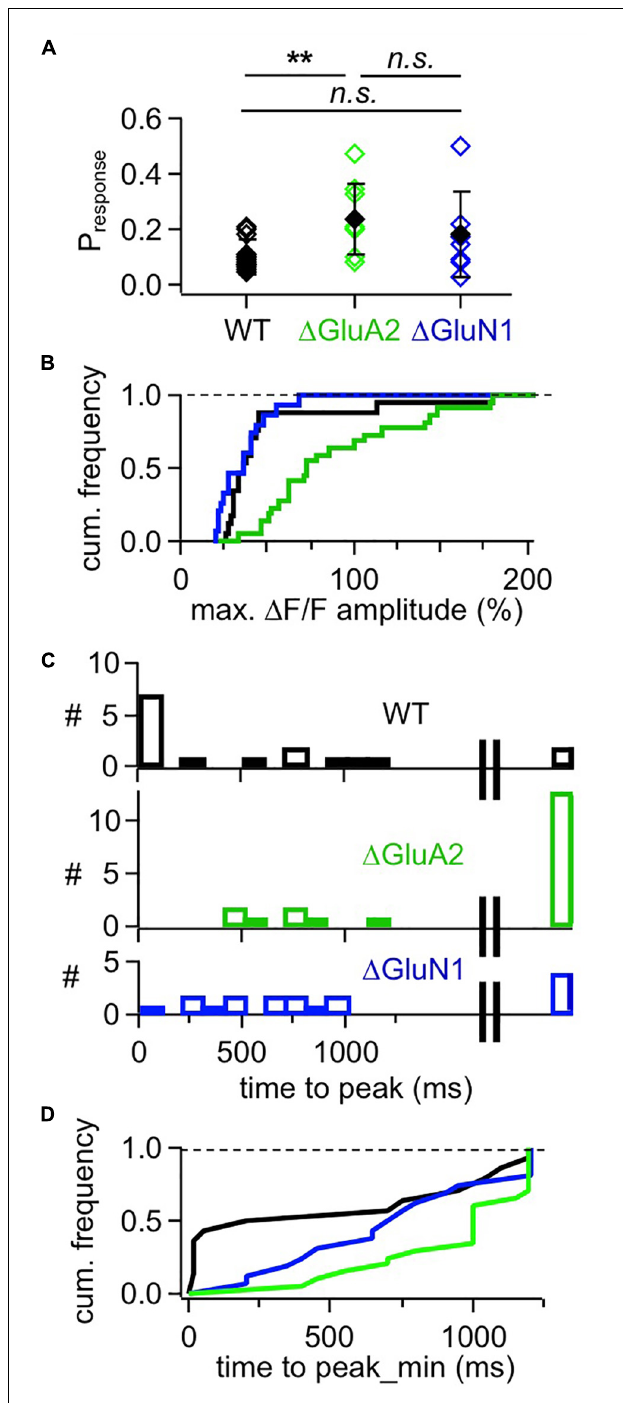
FIGURE 4 | Cumulative analyses of responses in adult mouse WT, (cid:49) GluA2 and (cid:49) GluN1 GCs. (A) Estimated likelihood of observing a ( (cid:49) F/F) syn response upon glomerular stimulation (“response probability,” calculated as number of responses divided by number of stimulations). Pairwise comparison (Mann-Whitney test) and Bonferroni: P r WT vs. (cid:49) GluA2: P = 0.0018, (cid:49) GluA2 vs. (cid:49) GluN1: P = 0.42, WT vs. (cid:49) GluN1: P = 0.51. (B) Frequency distribution of ( (cid:49) F/F) syn response amplitudes for the three GC groups. WT is different from